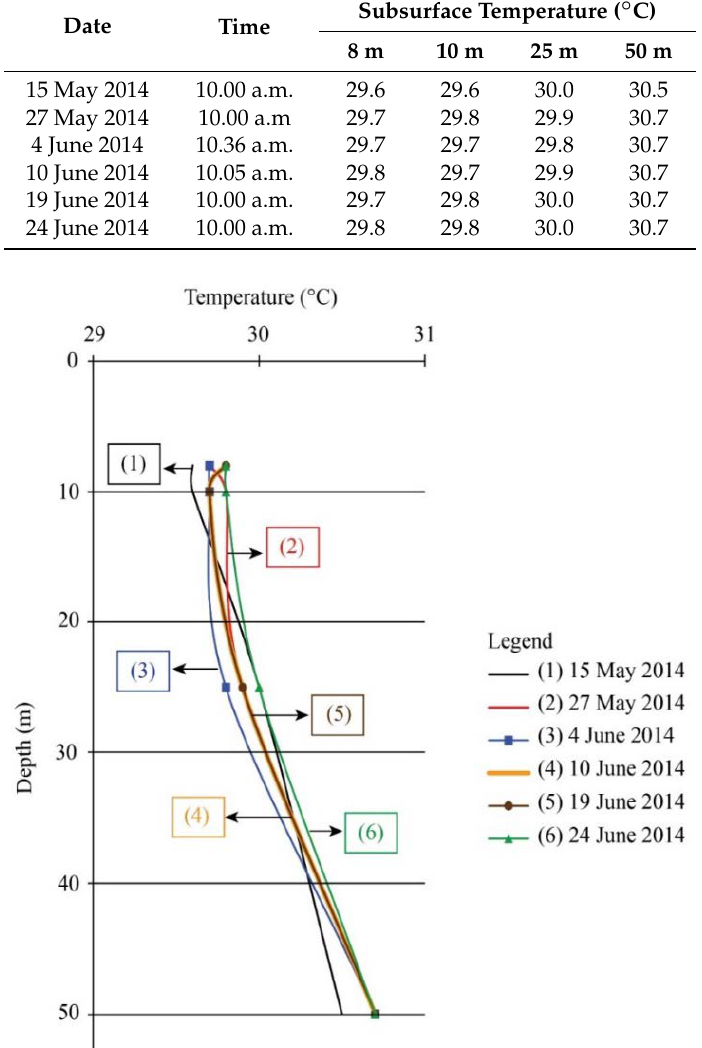
Figure 6. Temperature profiles of the observation well no. 1 and no. 2 at depths of 8, 10, 25 and 50 m at the Parot Racha Building, Chulalongkorn University. Noted that the data logger was installed in August 2014 together with thermistor at depth of 1.5 m (thermistor no. 2) and 3 m (thermistor no. 3). However thermistors at depths of 10, 25 and 50 m were broken so they were not able to use after